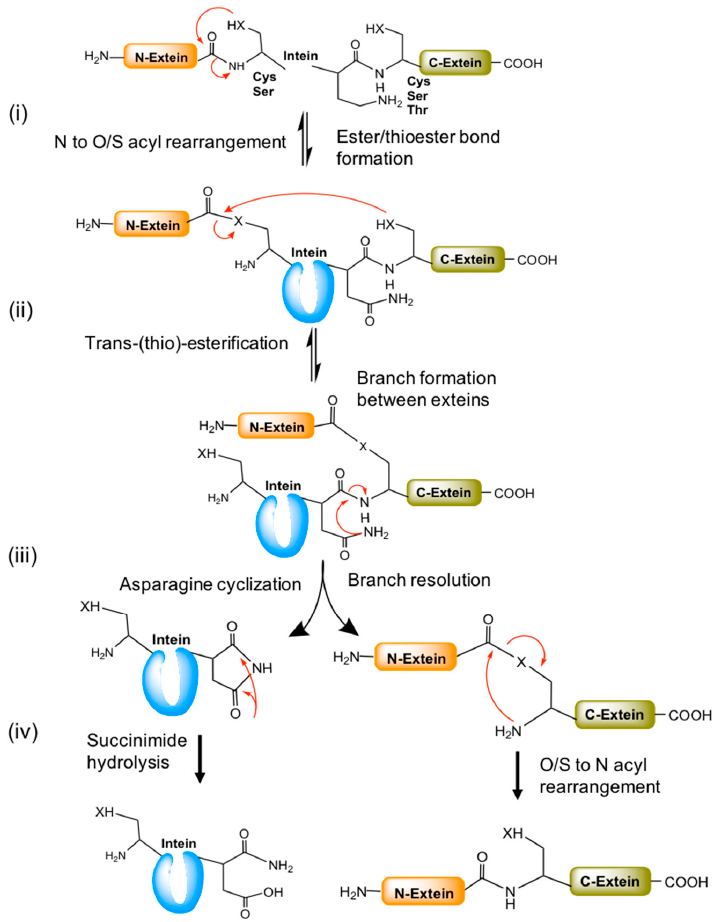
Figure 4. A general mechanism of the canonical splicing pathway. ( i ) Splicing begins with ester/thio-esterification (serine or cysteine residues) by N to O/S acyl rearrangement at the N-extein end. ( ii ) The esterified N-extein is linked to the C-extein by trans -(thio) esterification (by C, S or T). The branch resolution and Asn cyclization occurs in the next step with the help of conserved penultimate histidine residues. ( iii ) Later, the N- and C-exteins undergo O/S to N acyl rearrangement to form a new peptide bond between them. ( iv ) The cyclized asparagine converted into succinimide by hydrolysis. Red arrows represent the chemical reaction/s between the functional groups indicated. variation in the conserved amino acids of the N1, N2, C2, and C1 blocks (Blocks A, B, F, and G, respectively) (Figure 3). The lack of block-N2 or penultimate histidine in block-C1 affects the splicing process. For example, the Thermococcus kodakaraensis CDC21-1 (TkoCDC-21-1) intein has threonine instead of histidine at block-N2 [15]. In this case, a lysine residue (K58) residing outside of the standard intein conserved motifs seems to catalyze the initial N-S acylation reaction [15]. Similarly, the DnaE inteins of cyanobacteria have either serine or alanine in place of histidine at block-C1 [9]. These histidine residues are important for initiating N to O/S acyl rearrangement and asparagine